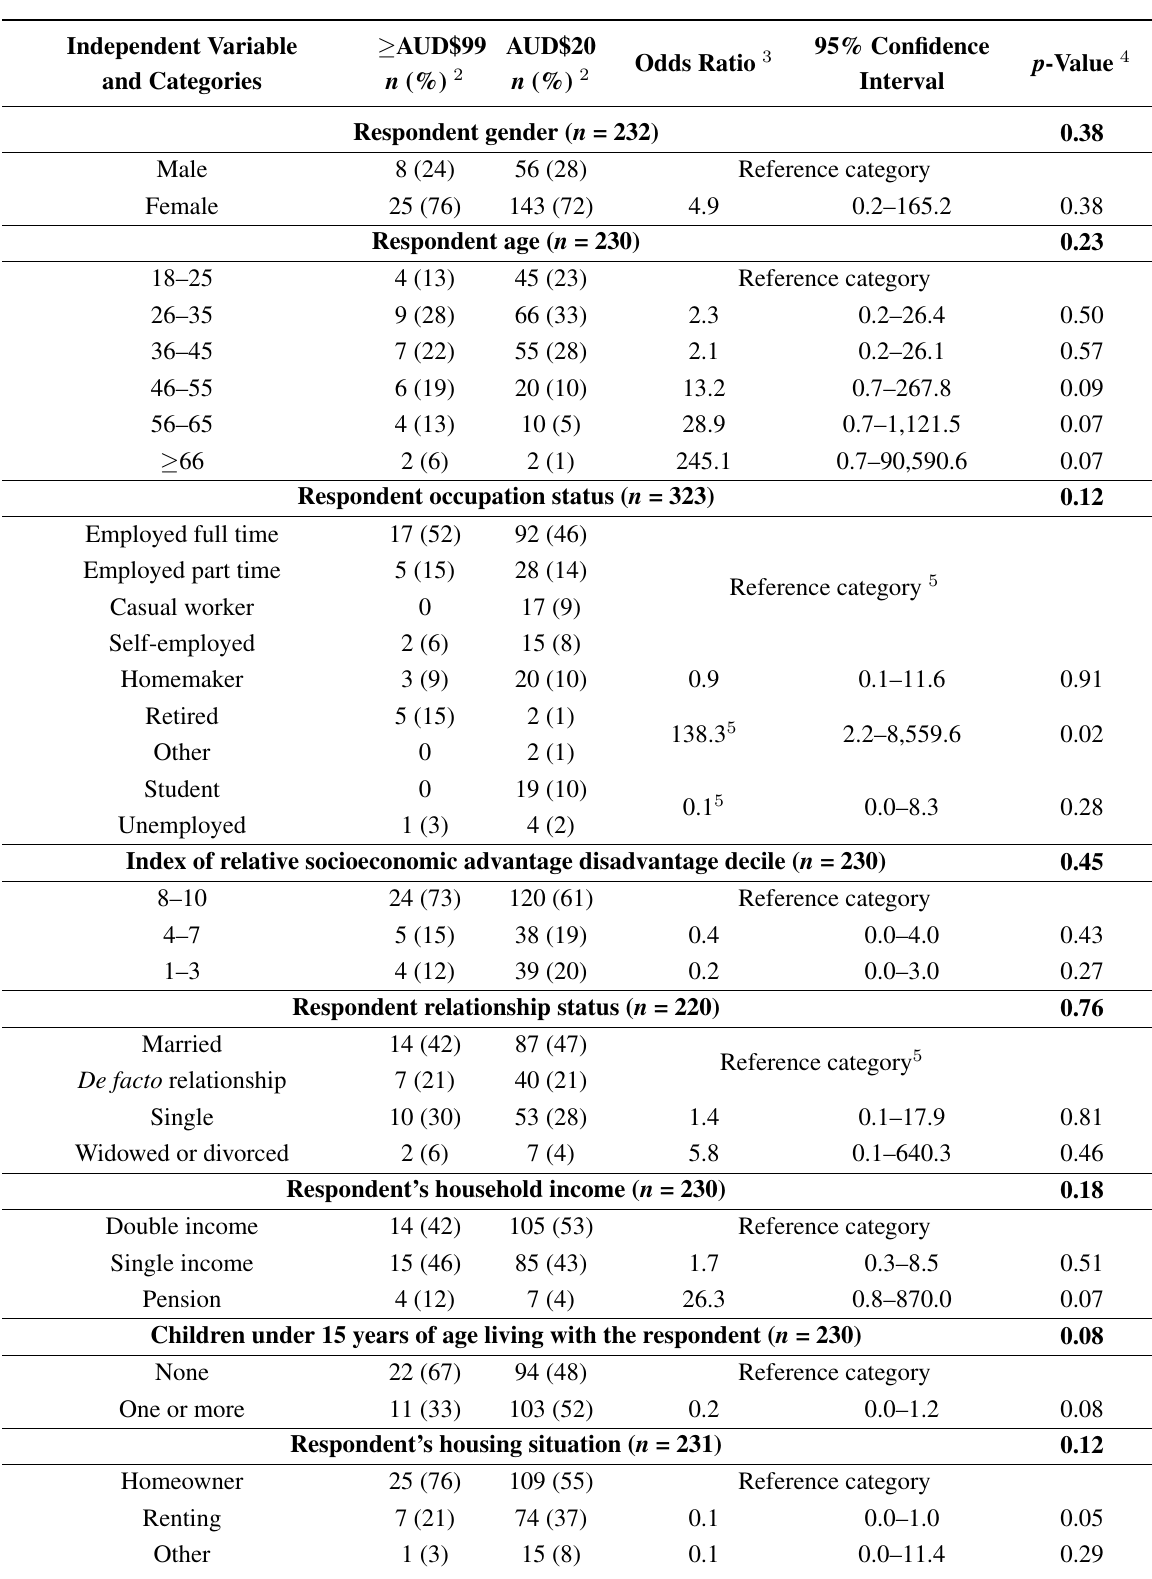
Table S3. Distributions of adult cats by adoption price and associations between potential determinants of cat adoption price for 248 adult cats adopted from an animal shelter in Australia in 2013 1